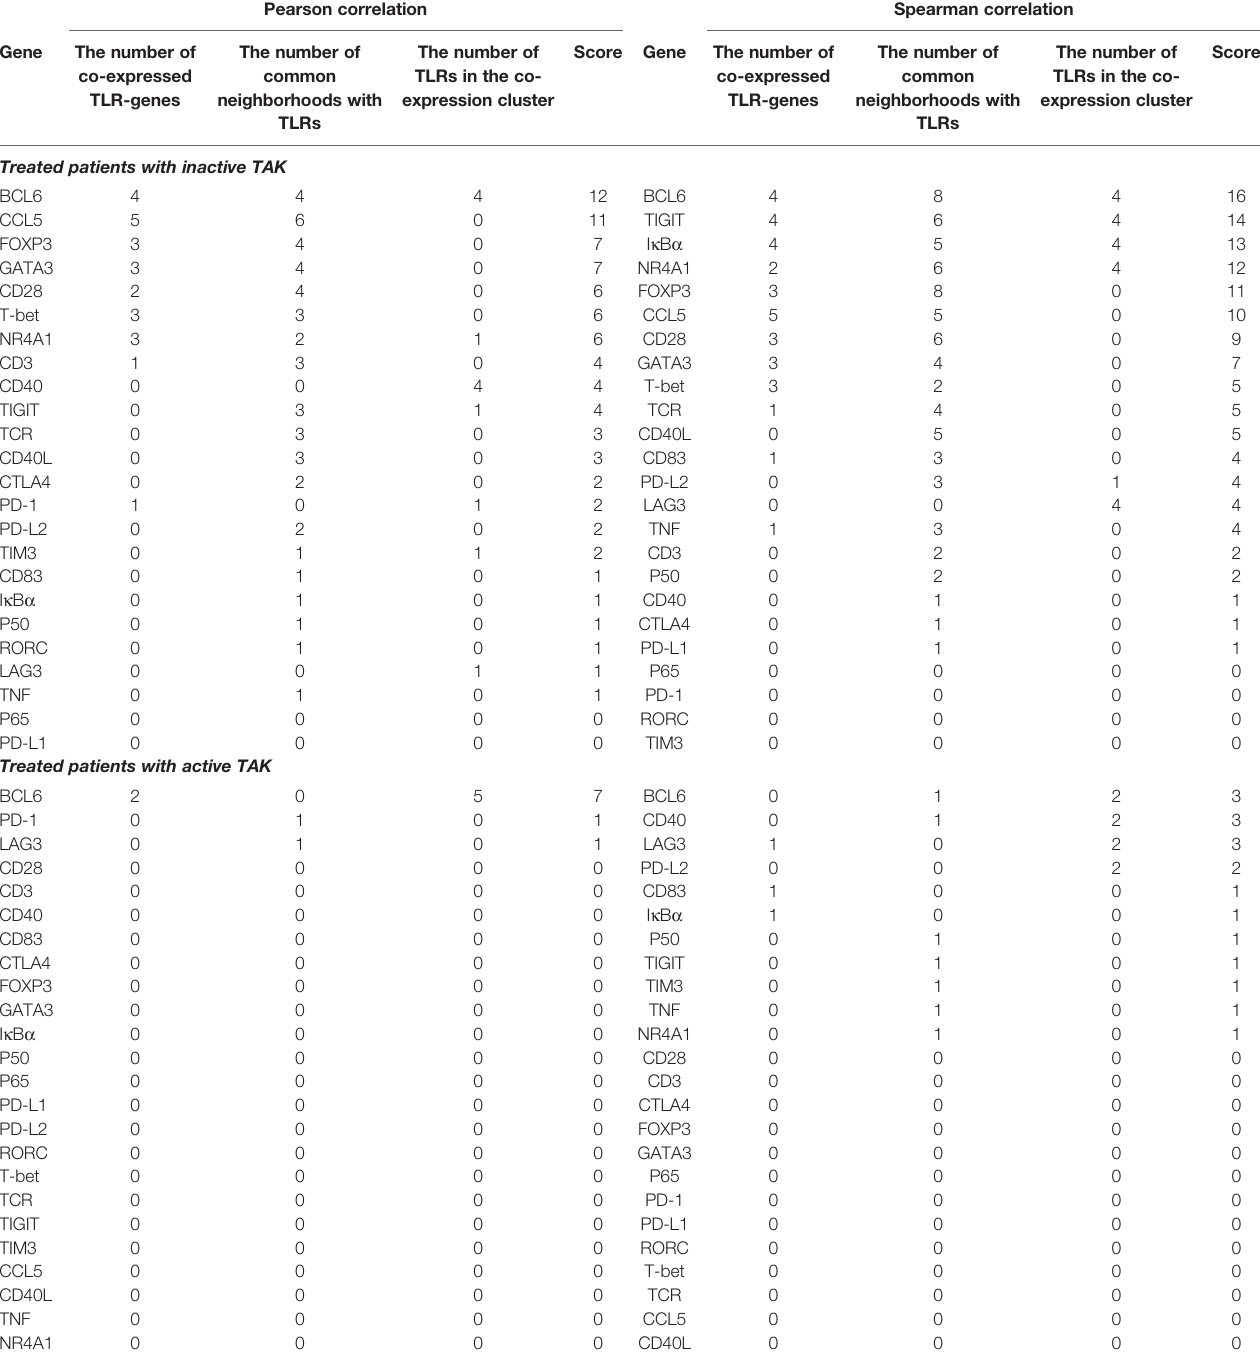
TABLE 3 | Evaluation the closeness of gene-to-gene functional relationships between TLRs and the other genes. Pearson correlation Spearman correlation Gene The number of The number of The number of Score Gene The number of The number of The number of Score co-expressed common TLRs in the co- co-expressed common TLRs in the co- TLR-genes neighborhoods with expression cluster TLR-genes neighborhoods with expression cluster TLRs TLRs Treated patients with inactive